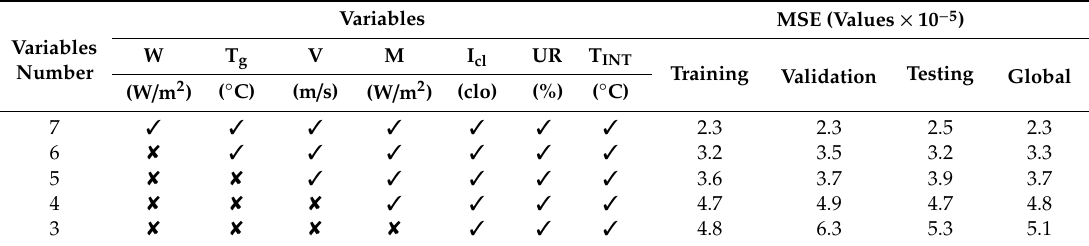
Table 5. Sensitivity analysis by varying the number of variables to be provided for the implementation of ANN: Mean Square Error (MSE)